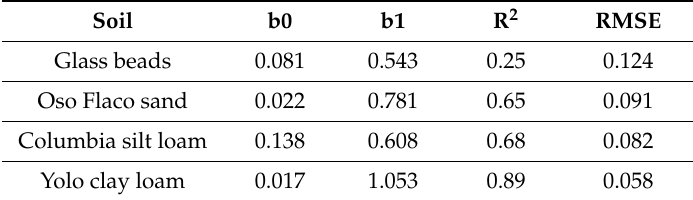
Table 4. Summary of combined probe calibration functions of the form: y = b0 + b1x.